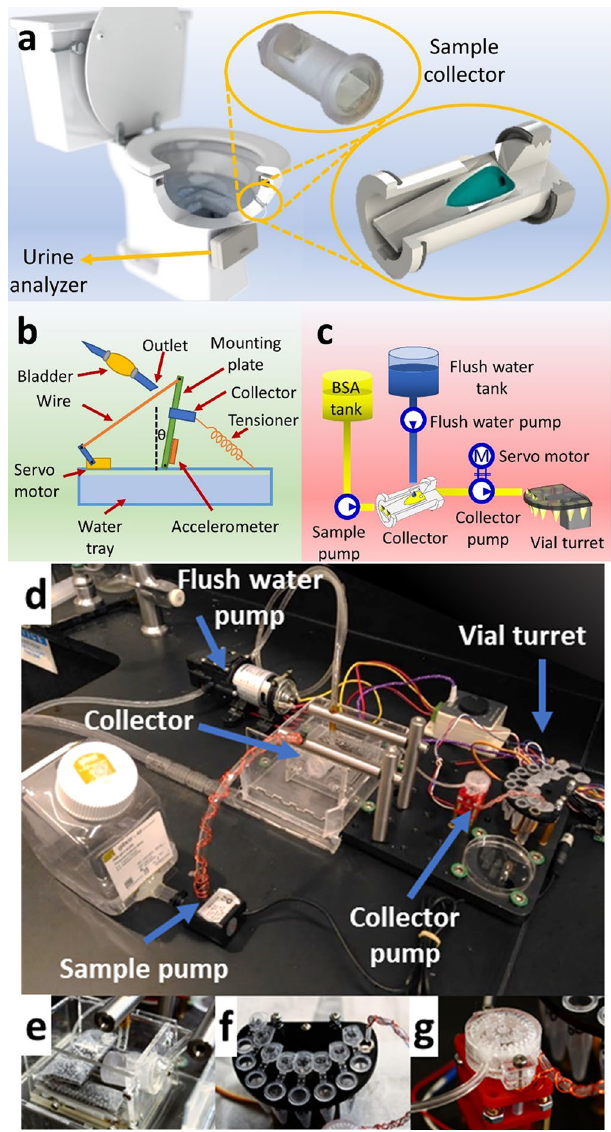
Figure 1. Design and characterization of a few hundred microliter-scale sample collector for a toilet-based urine analysis module. ( a ) Illustration of a sample collector and a non-disclosed urine analyzer integrated into a toilet. The insets show the 3D-printed prototype and further CAD details of the reservoir where the liquid will be collected. ( b ) Schematic view of the experimental setup for optimizing the collector design, composed of an acrylic plate to hold the collector, an accelerometer to measure and two servo motors to control the angle of the plate, a pump, and a 10 mL falcon tube with a drill hole at the bottom to act as an ejector. ( c ) Hydraulic circuit of the experimental setup for assessing the long-term cyclic use of the collector, including the flush water pump, sample pump, collector pump, collector, and vial turret. ( d ) Image of full experimental setup for studying the long-term cyclic use of the sample collector. ( e ) The collector held at a 10° angle by a laser-cut acrylic holder, positioned in a plastic tray. ( f ) Vial turret containing 8 vials and one drainage tube. The turret actuated by an attached servo motor that rotates 20° clockwise for each collection. ( g ) 3D-printed custom-designed peristaltic collector pump powered by a DC motor located under the pump, held in place by a laser-cut acrylic